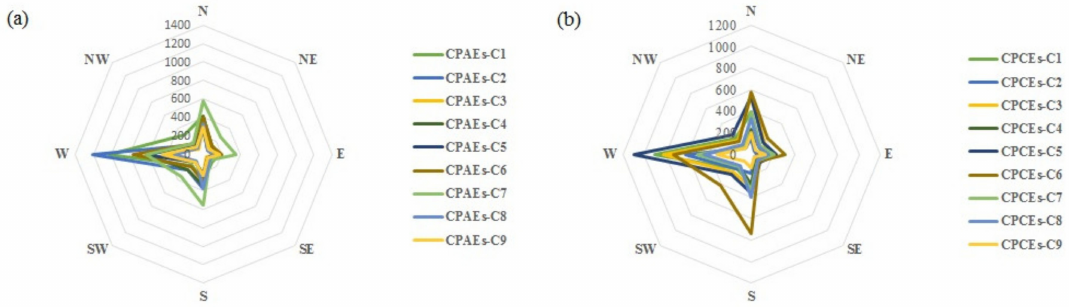
Figure 12. The inter-community movement directions of CPAEs ( a ) and CPCEs ( b